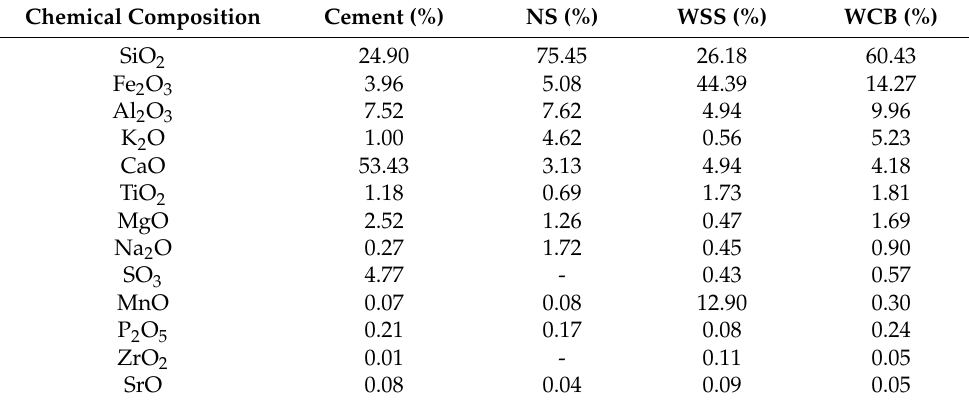
Table 1. Chemical composition of cement, NS, WSS and WCB.